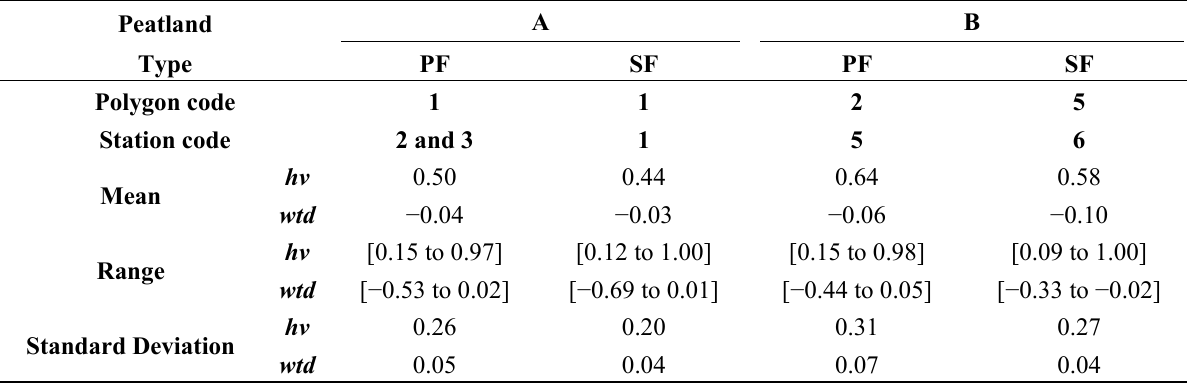
Table 3. Statistics of soil moisture and water table depth ground measurements per polygon (years 2009 and 2010): volumetric soil moisture ( hv ) in m 3 ·m − 3 ; water table depth ( wtd ) in m (the surface soil level being